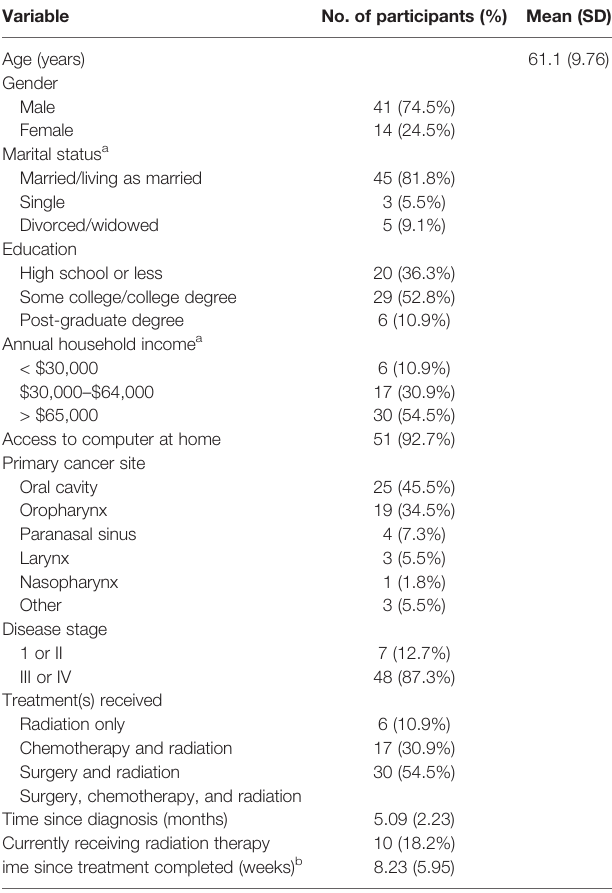
TABLE 1 | Participant Demographic and Clinical Characteristics (n = 55).